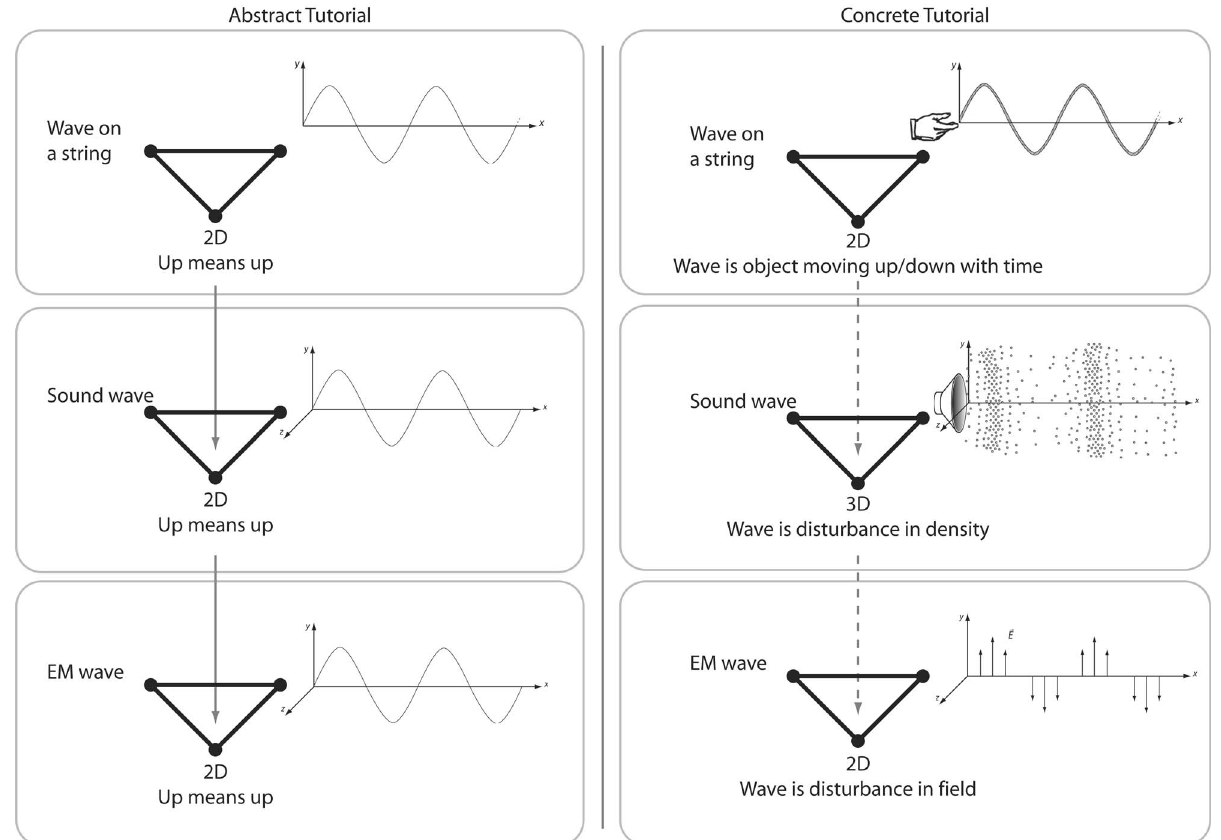
FIG. 4. Analogical scaffolding schematics for the abstract (cid:1) left (cid:2) and concrete (cid:1) right (cid:2)